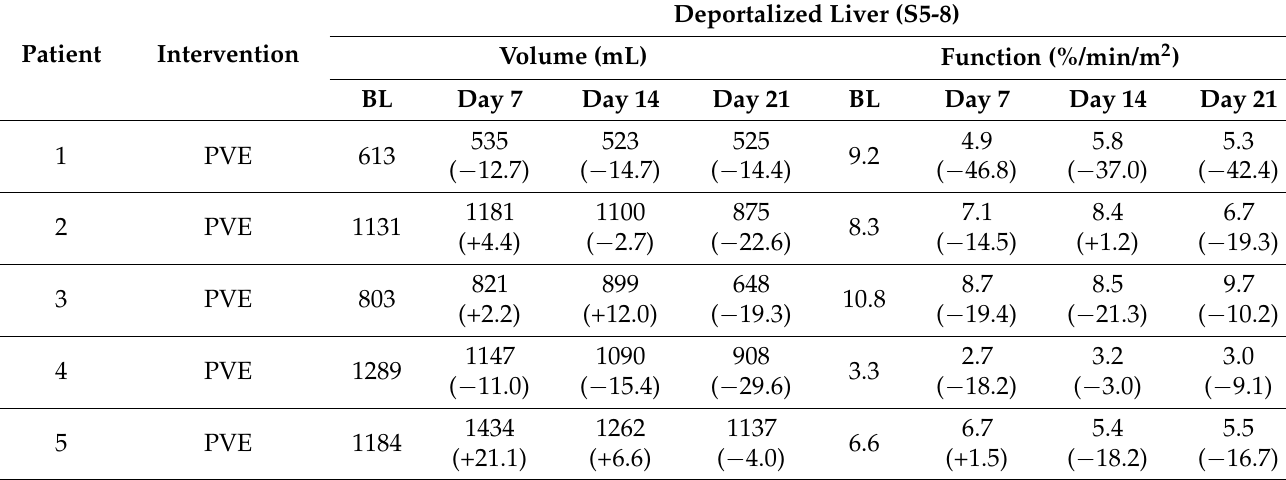
Figure 2. Variations in volume and function from baseline in the deportalized liver (S5-8) at days 7, 14 and 21 after PVE. Table 2. Volume and function raw data in the deportalized liver (S5-8 after PVE).